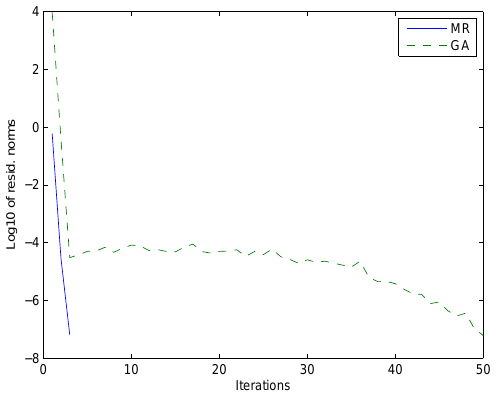
Figure 1. Galerkin approach (GA): dashed line, minimal residual (MR): solid